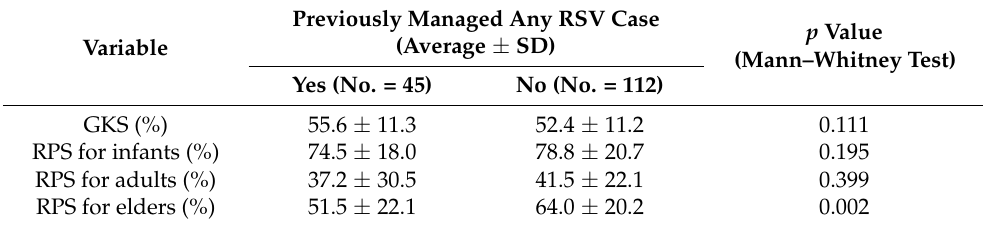
Table A2. Comparison of cumulative scores by having or not previously managed any RSV case (Note: SD = Standard Deviation).